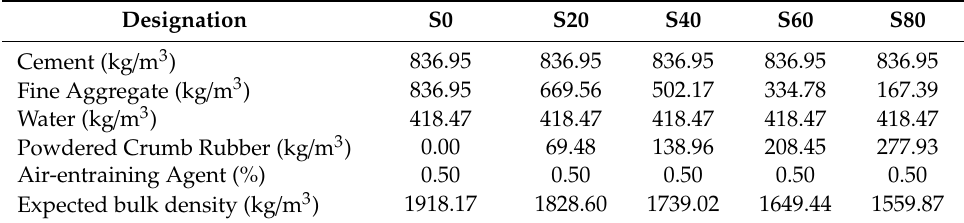
Table 1. Material details of di ff erent mix proportions.